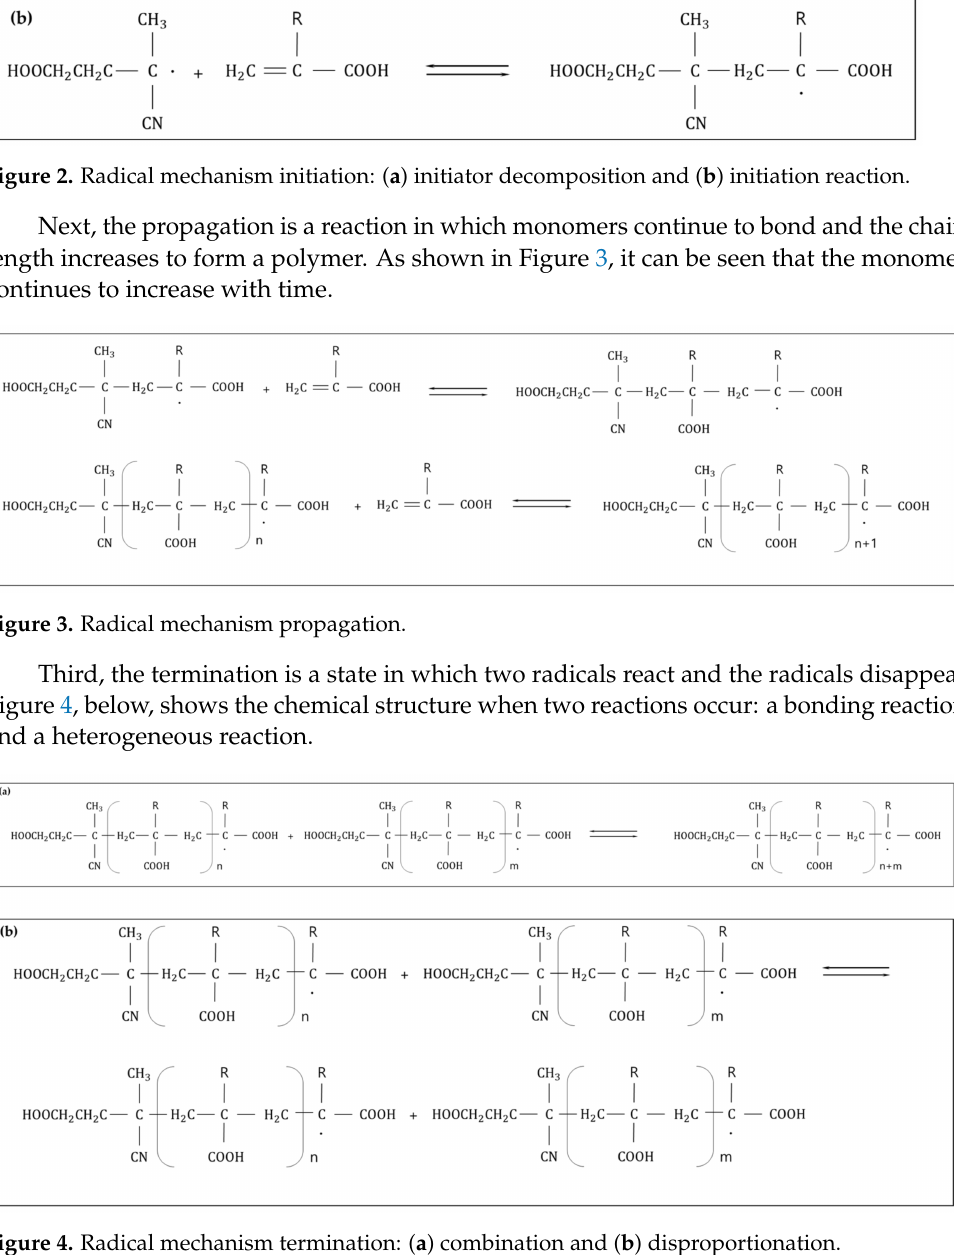
Figure 4. Radical mechanism termination: ( a ) combination and ( b )